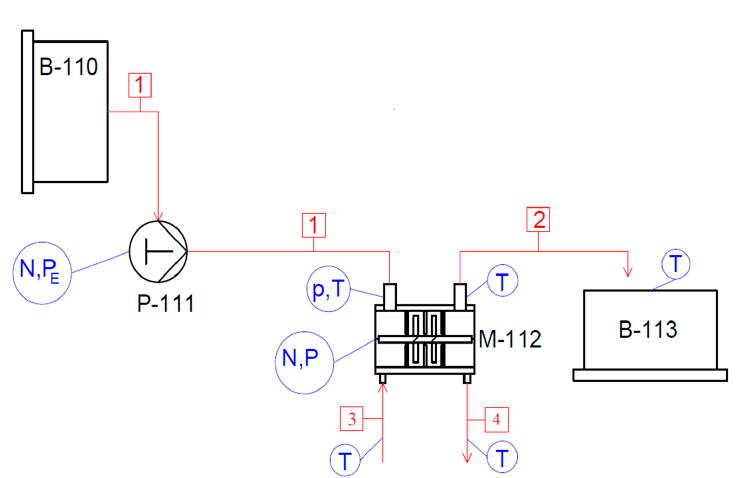
Figure2. Experimentalset-up. Measuredquantities: N—rotationalspeed, p—pressure, T—temperature,